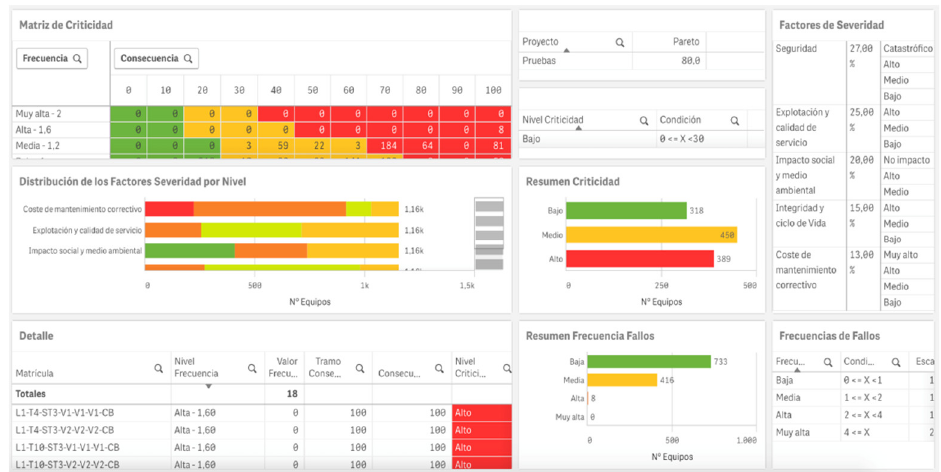
Figure 15. Sample results presented by the BI of the asset criticality analysis APP.